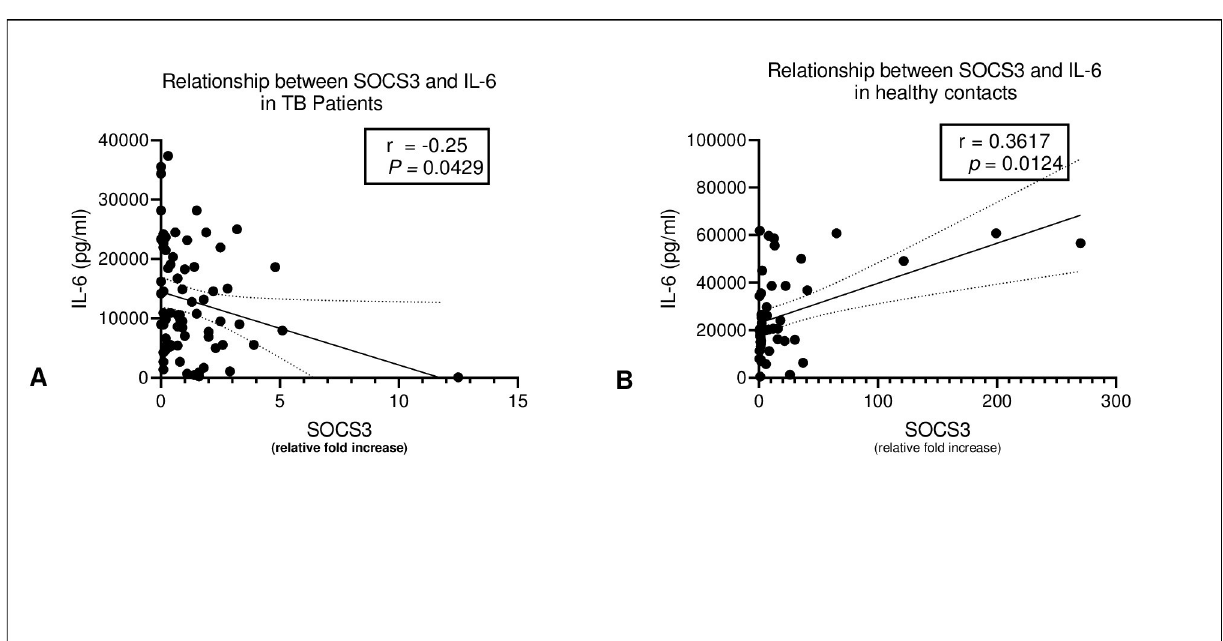
Fig 6. A: Shows a negative correlation between post-stimulation expression SOCS3 and IL-6 in TB patients and B shows a positive and significant correlation between post-stimulation expression SOCS3 and IL-6. The relationship between SOCS3 and IL-6 was assessed using spearman’s rank